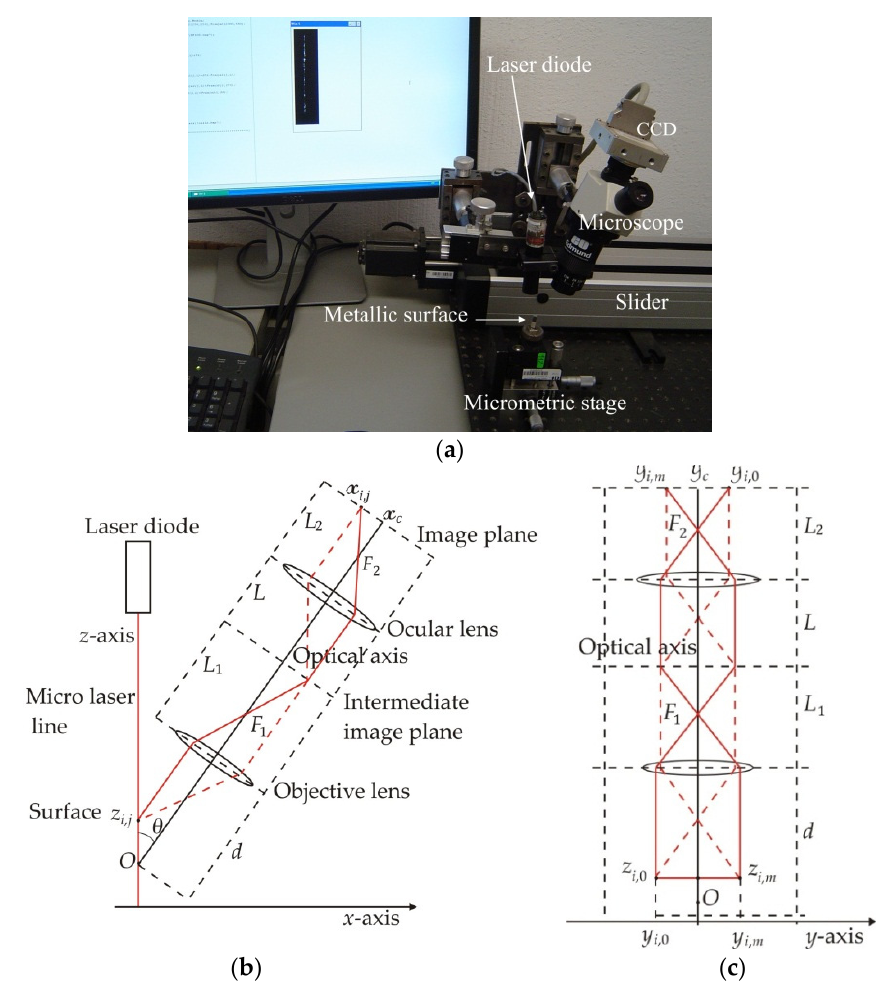
Figure 4. ( a ) Microscope vision system to compute micro-scale flat and free-form topography [37]. ( b ) Lateral geometry of the microscope system in x -axis. ( c ) Geometry of the microscope system in y -axis.